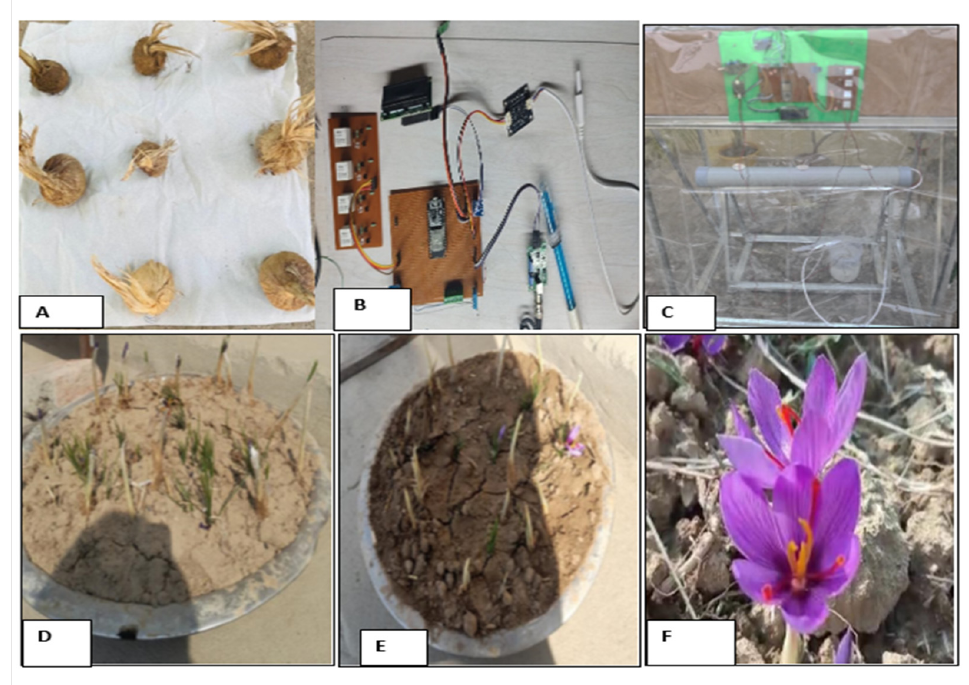
Figure 2. ( A ) Saffron corms dried after treatment with fungicidal solution;( B ) hardware components for artificial environment; ( C ) artificial saffron cultivation set up;( D ) saffron corms sown in natural medium; ( E ) sprouting of saffron corms;( F ) flowering of corms.